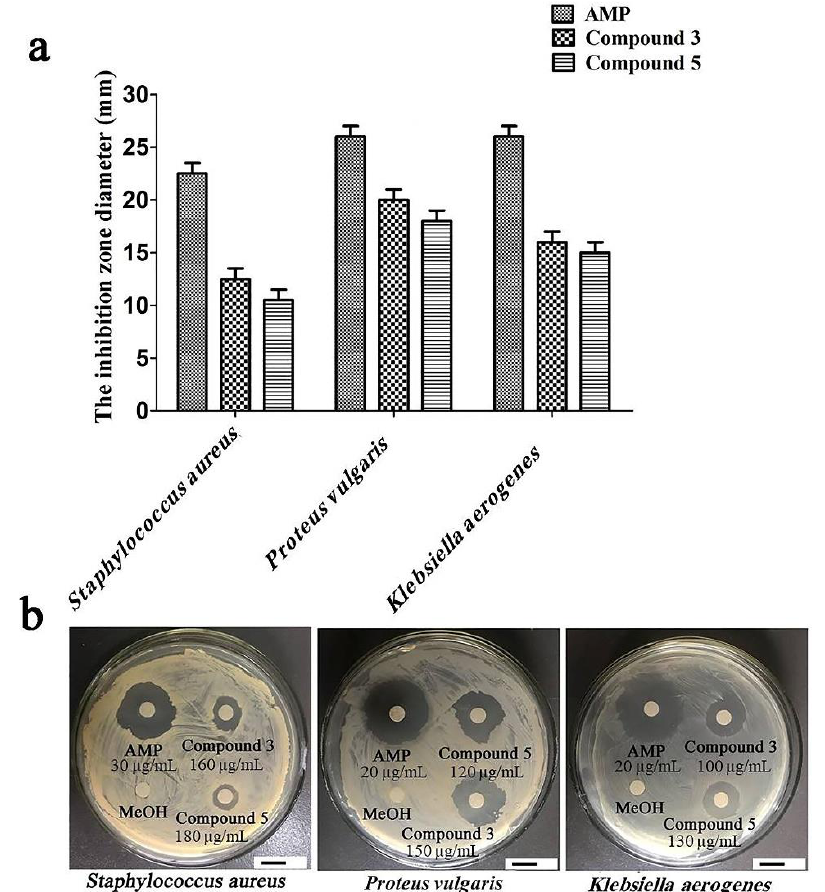
Figure 5. The inhibition zone diameter. ( a ) shows the inhibitory zone diameter of AMP, compound 3 and compound 5 against Staphylococcus aureus , Proteus vulgaris and Klebsiella aerogenes at the MICs (the MICs of AMP, compound 3 and compound 5 for Staphylococcus aureus are 30 µg/mL, 160 µg/mL and 180 µg/mL, for Proteus vulgaris are 20 µg/mL, 120 µg/mL and 150 µg/mL, and for Klebsiella aerogenes are 20 µg/mL, 100 µg/mL and 130 µg/mL, respectively). ( b ) shows the antibacterial activity of the AMP, compound 3 and compound 5 on the three indicator bacteria. Scale bar = 10 mm.